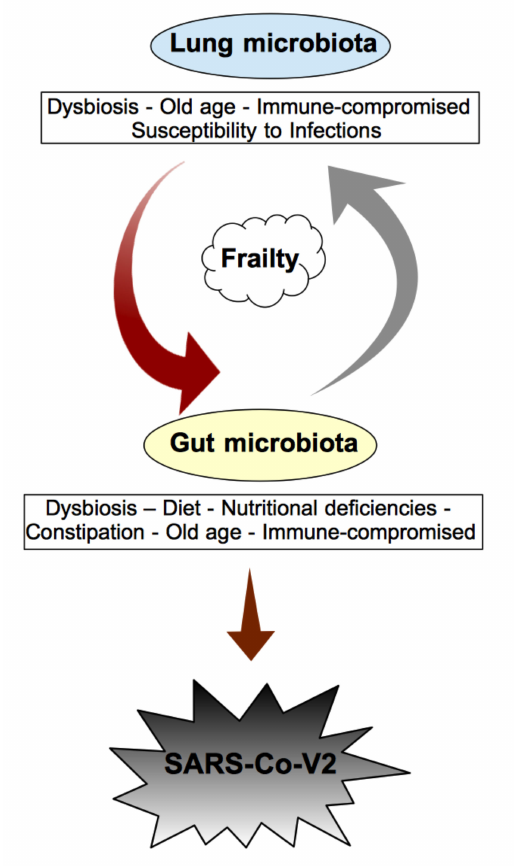
Figure 1. Schematic representation of the bidirectional link between lung and gut. The gut microbiota influences lung health through a cross dialogue between the gut microbiota and the lungs, the “gut– lung axis”. The functional state of the elderly, dysbiotic condition, immune compromise, nutritional deficiencies constitute as a whole, a condition of extreme